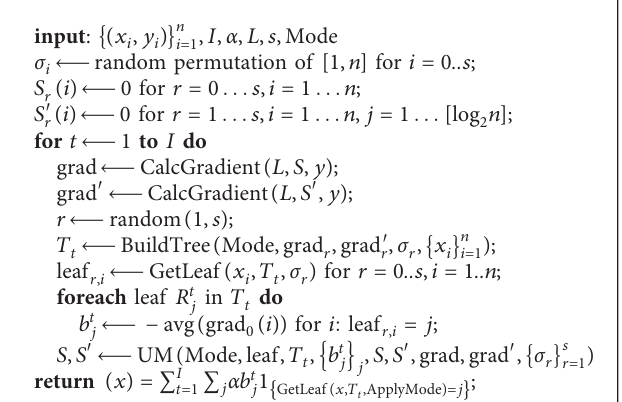
samples are tagged with the category labels of I, II, III, IV,